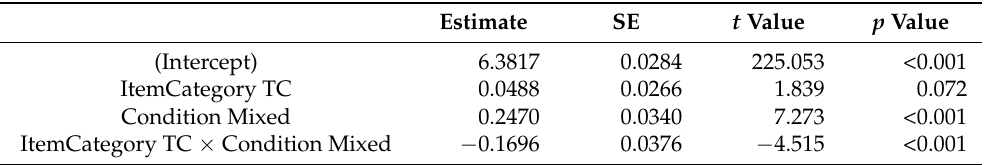
Table 4. Output of the LMER model for L2 tasks with item category (cognate or target language control word (TC)) and condition (pure or mixed language condition) as fixed effects.